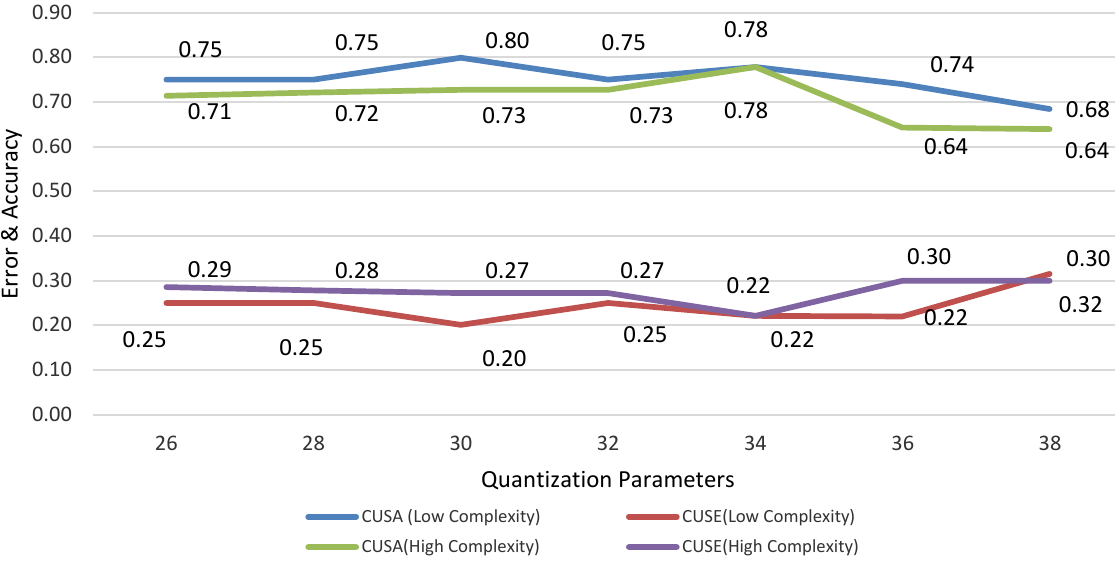
Figure 13. CUS A and CUS E variation based on encoding complexity changes in various QP